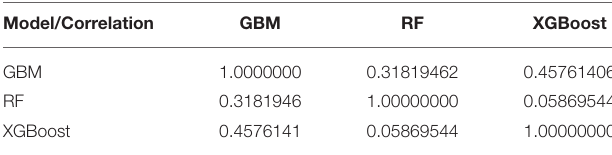
TABLE 4 | Correlation of the models in the Ensemble Model: Random Forest (RF), Extreme Gradient Boosting (XGBoost), and Gradient Boosting Machine (GBM). Model/Correlation GBM